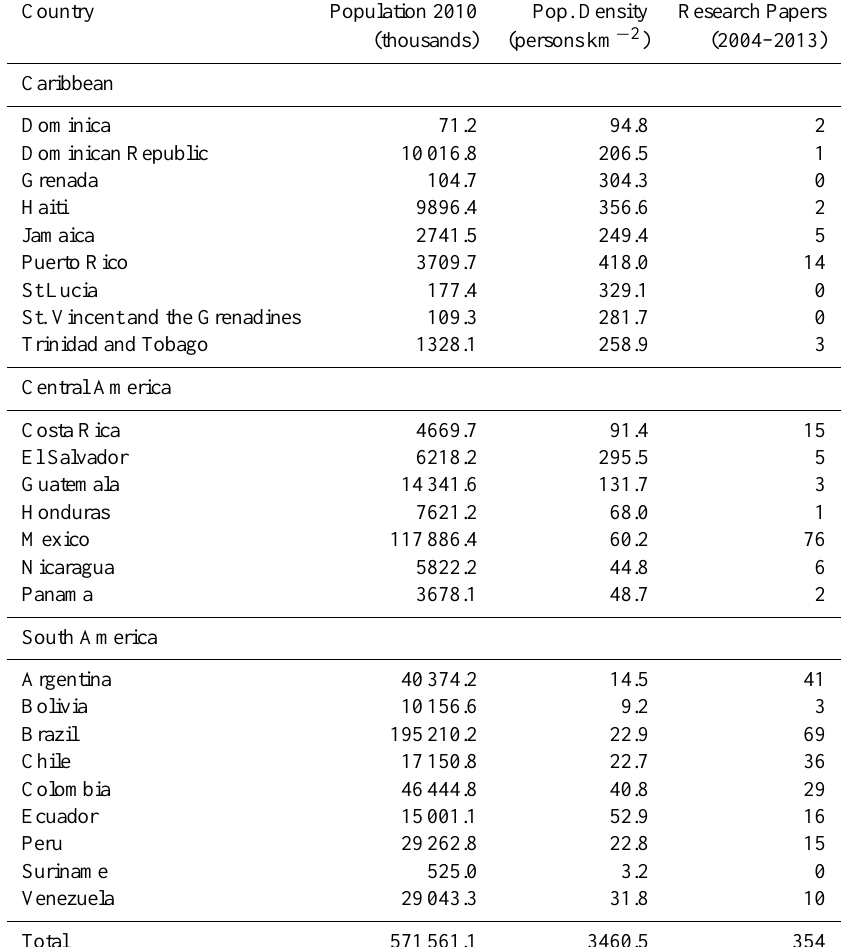
Table 2. Population data (United Nations, 2013) and scientific research on landslides indices (ISI Web of Science) for those countries with fatal landslides during